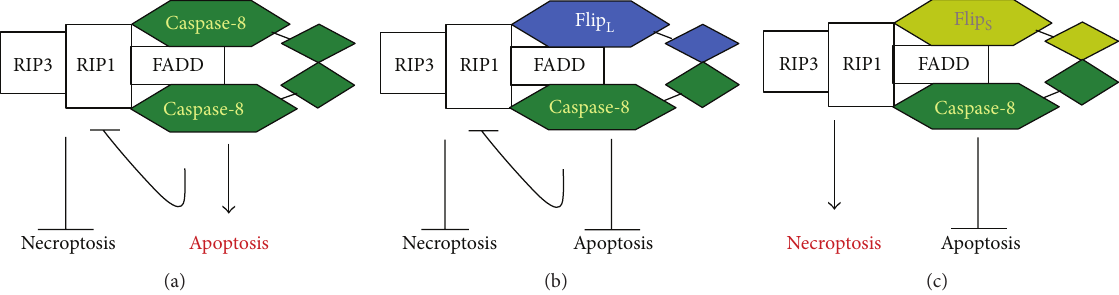
Figure 1: (a) Dimerization of caspase-8 drives apoptosis initiation without triggering necroptosis. (b) c-Flip L /caspase-8 heterodimer, by leading to reduced caspase-8 activity, can induce neither apoptosis nor necroptosis. (c) c-Flip S /caspase-8 heterodimer, by inhibiting caspase- 8, leads to necroptosis